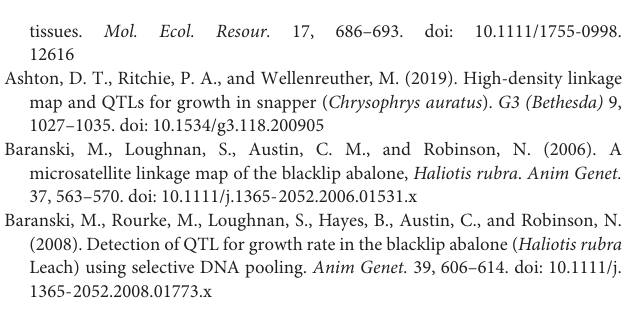
Supplementary Table 7 | Details of SNPs that used to construct the linkage